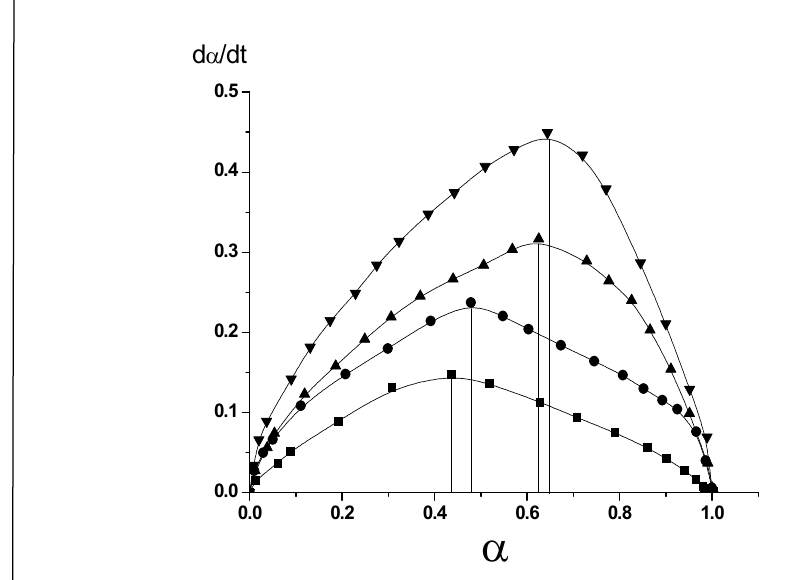
Figure 2 – The dependence of / d dt  on  at various heating rates: ■ - 5 K min -1 , ● - 10 K min -1 ▲ - 15 K min -1 ▼ - 20 K min -1 Рис . 2 – зависимость / d dt  при разных скоростях нагревания : ■ - 5 K мин -1, ● - 10 K мин -1 ▲ - 15 K мин -1 ▼ - 20 K мин -1 Слика 2 – зависност / d dt  на различитим брзинама загревања :